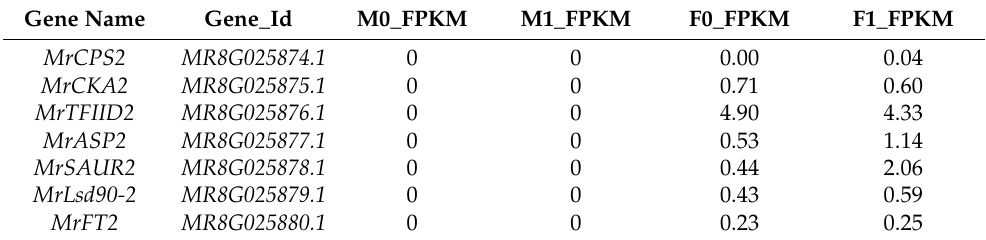
Figure 4. The distribution and expression of transcription factor genes in all 8889 DEGs. ( a ) The distribution of 547 transcription factor genes (top 12 families). ( b ) Heat map of sex-biased DEGs related to transcription. The FPKM value of genes is shown in the box. Table 1. List of the expression level of seven female-specific genes in red bayberry floral